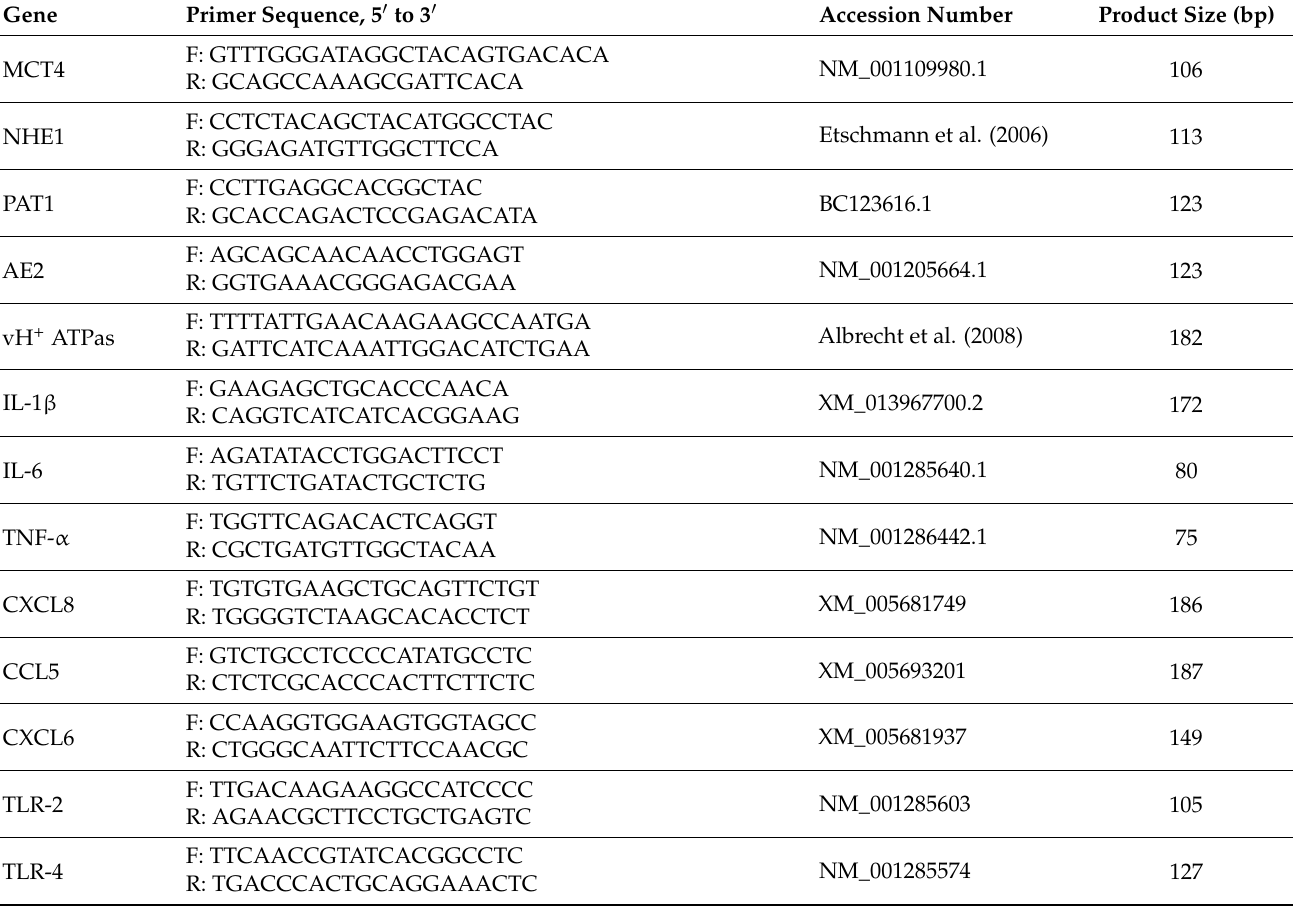
Table 1. Primers for real-time PCR